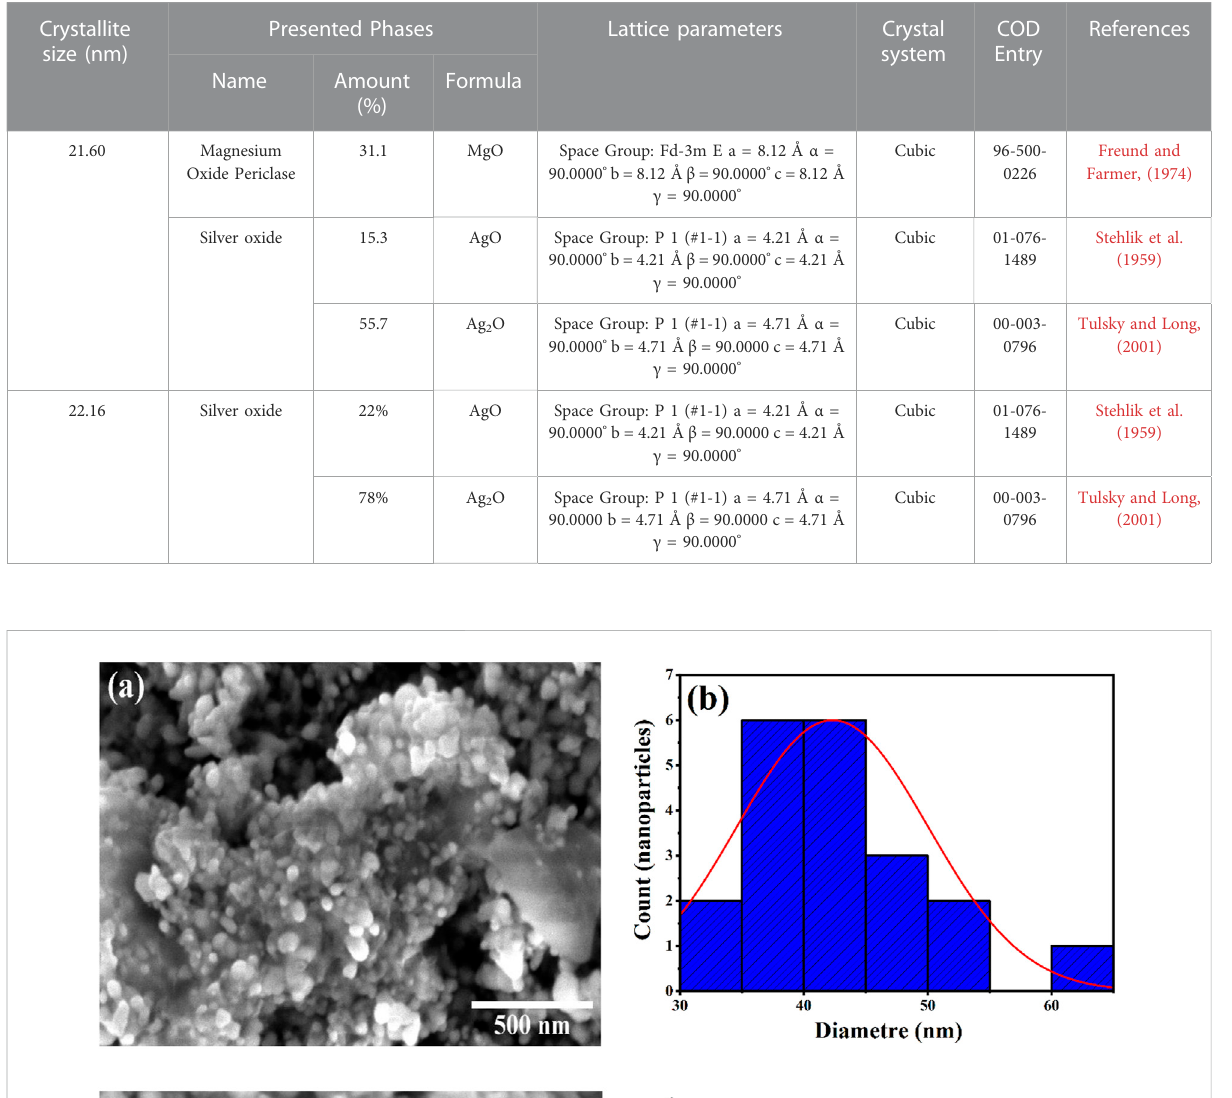
TABLE 1 Quanti fi cation and average crystallite size of AgO/Ag 2 O and MgO@AgO/Ag 2 O NPs.